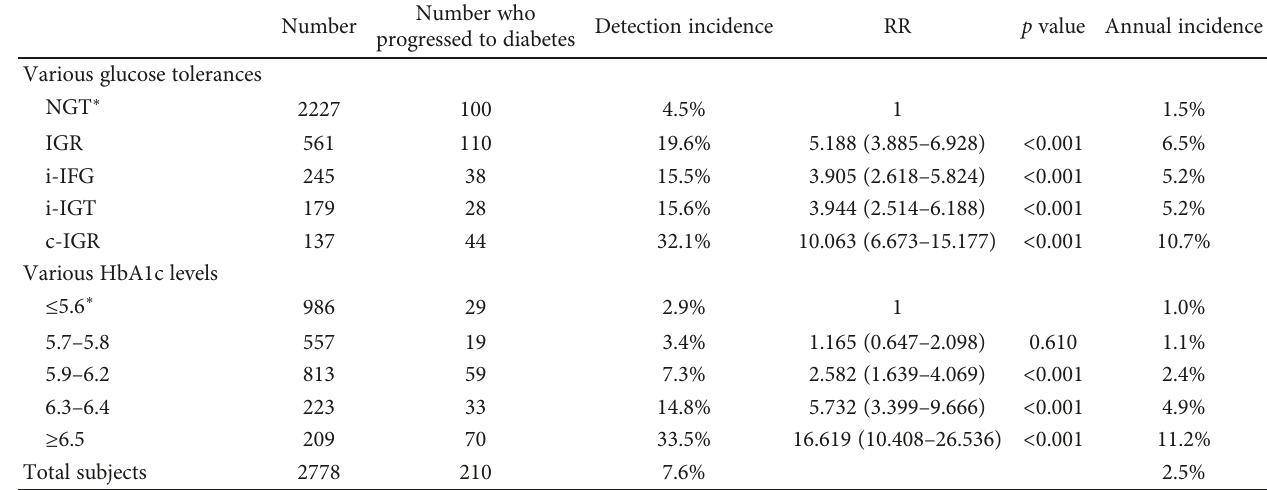
Table 2: Incidence rates of diabetes among glucose regulation subgroups after 3 years of follow-up.